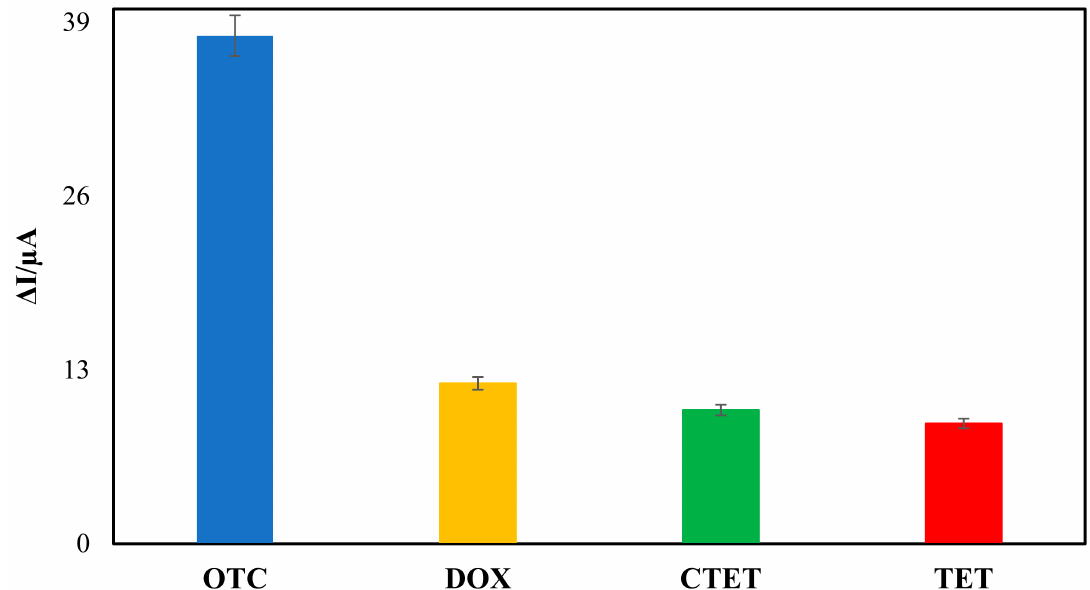
Figure 6. Selectivity of the aptasensor for OTC detection by comparing it to the interfering agents, including tetracycline (TET) and two structurally similar tetracycline derivatives (DOX, CTC) at the concentration of 50.0 nM.